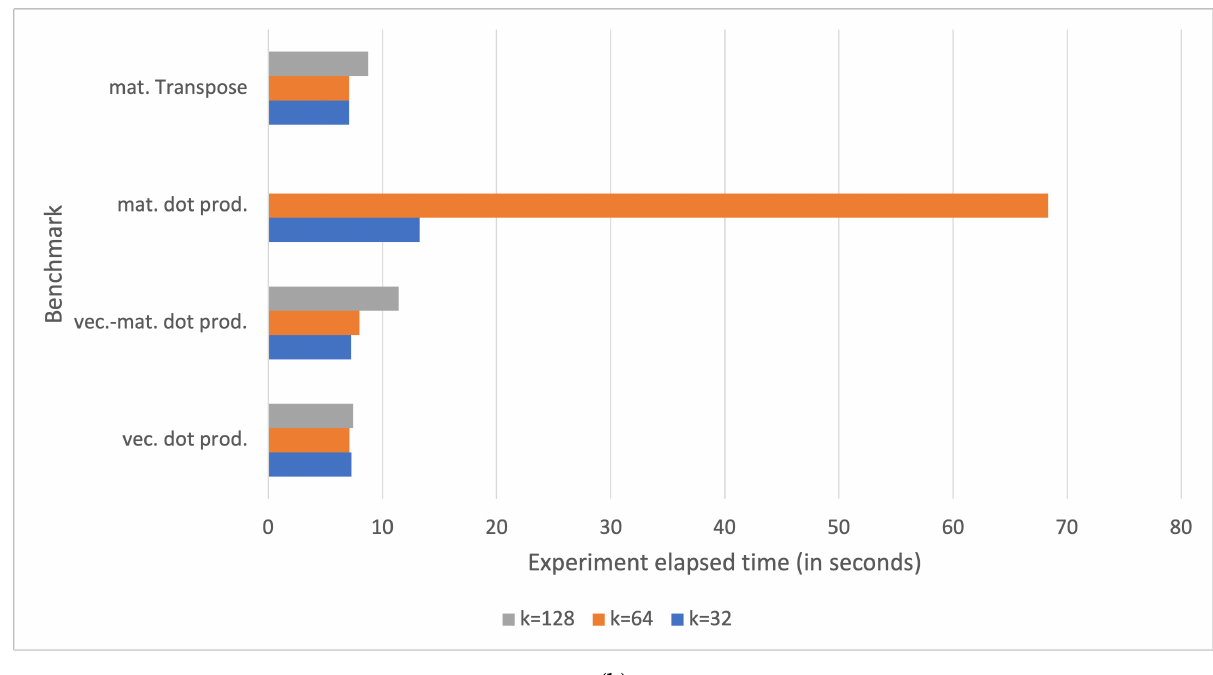
Figure 12. Elapsed time for running all the measurements on a Raspberry Pi IV for ( a ) tensor operation benchmarks, and ( b ) vector and matrix operation benchmarks.